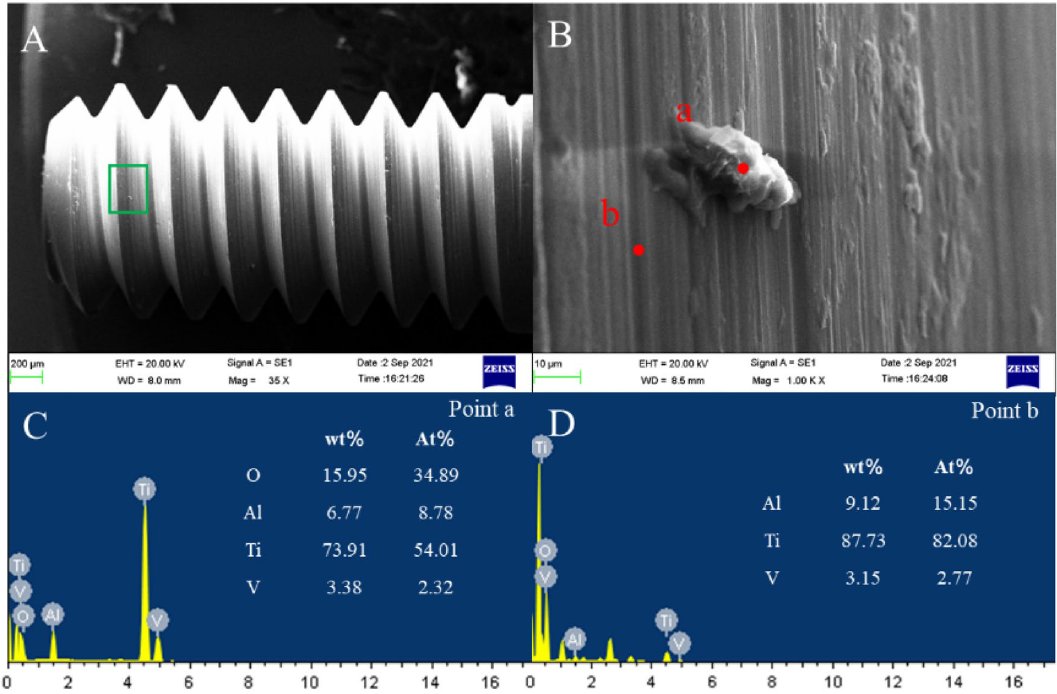
Figure 8. Screw surface wear in the MC group. ( A ) Screw morphology, ( B ) area shown in ( A ), ( C ) EDS at point (a), and ( D ) EDS at point